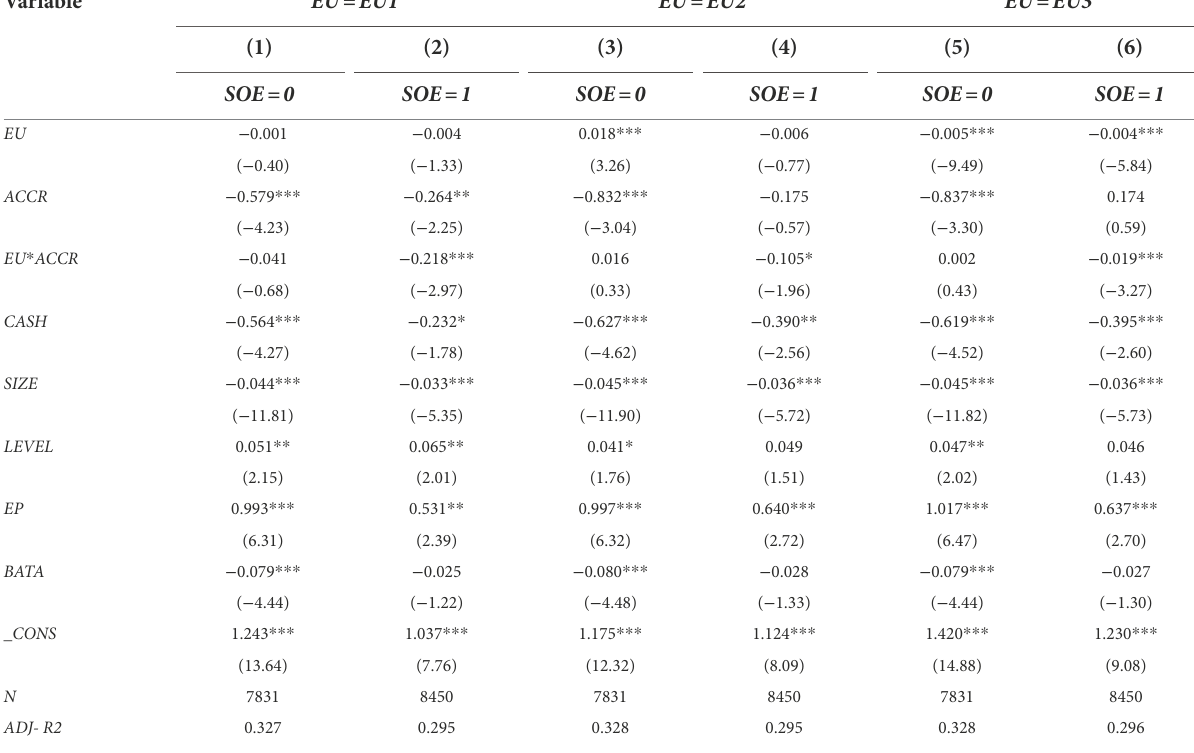
TABLE 5 The relation between environmental uncertainty and accrual anomaly in Group 1.